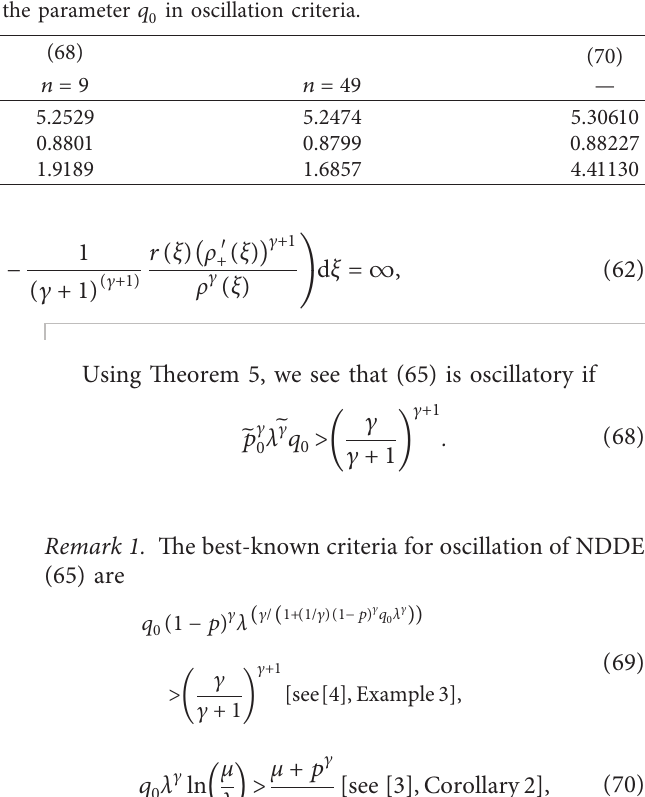
Table 1: The lower boundaries of the parameter q